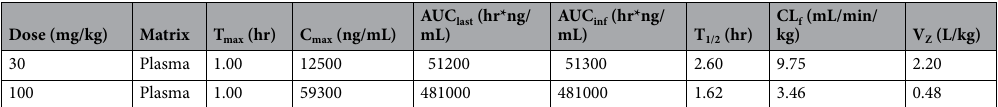
Table 2. Pharmacokinetics of CCR2 antagonist INCB3344 after oral administration. Pharmacokinetic profile of CCR2 antagonist INCB3344 in plasma following a single oral dose administration to male C57BL/6 mice (Dose: 30 and 100 mg/kg). CL expressed as CL f and V ss expressed as V z